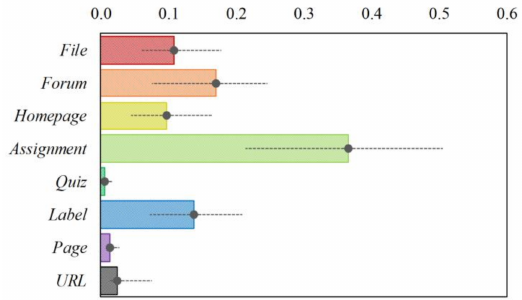
Figure 6. The global feature importance from the data set involving recorded activities of all